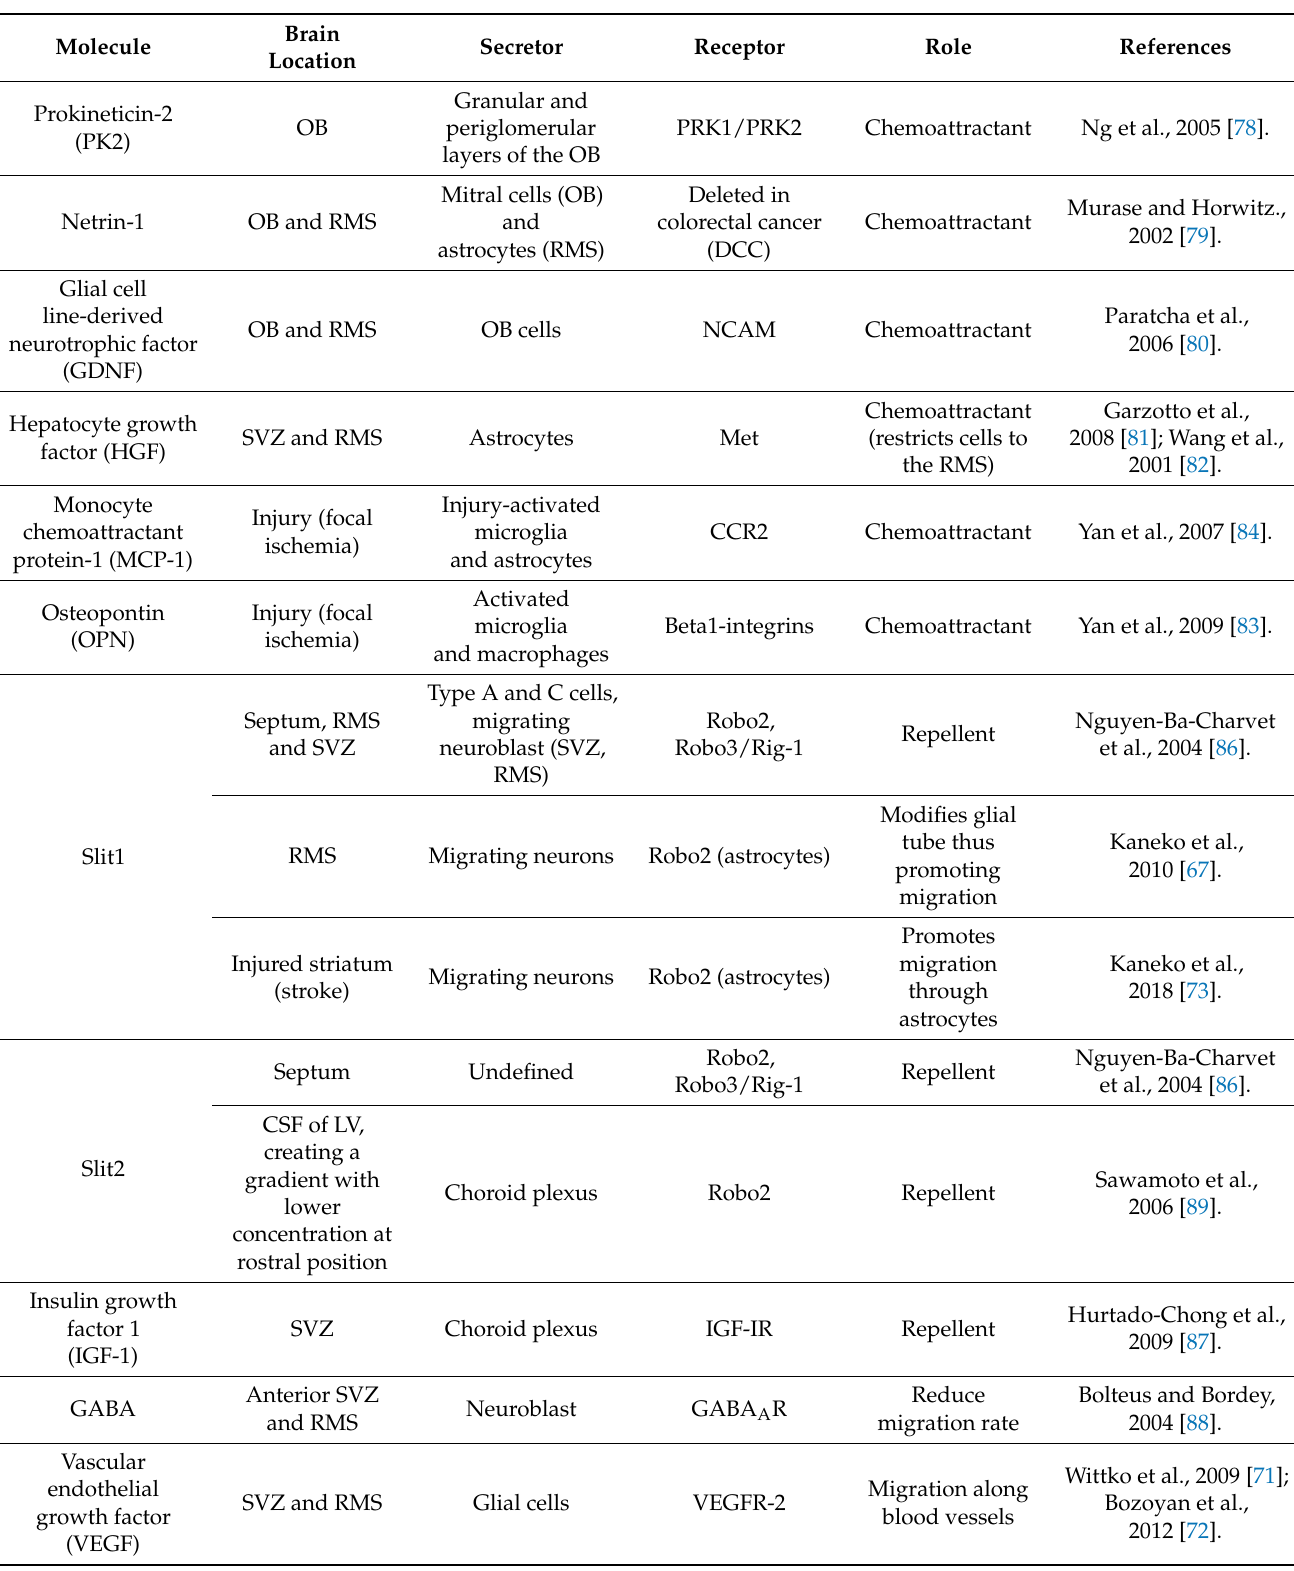
Table 1. Molecules involved in neuroblast